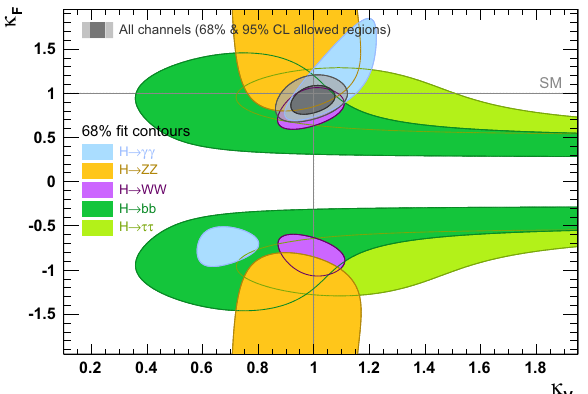
Fig. 13 Validation of our implementation of the combined ATLAS and CMS Higgs boson coupling measurements: preferred regions from a two-dimensional scan of the coupling strength modifiers κ V and κ F for individual Higgs boson decay channels and their